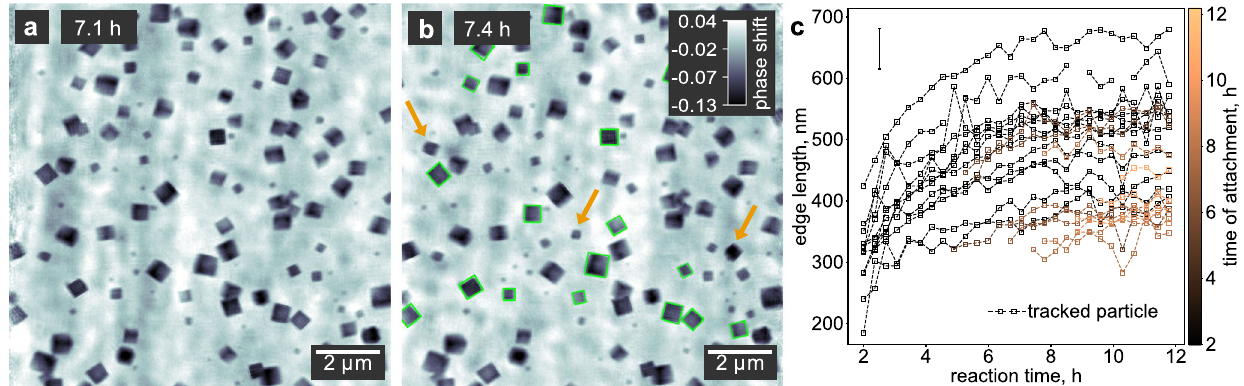
Fig. 3 | Analysis of the growth process from a 2D perspective. a , b In situ ptychographic images taken at 7.1 and 7.4h, respectively. Particles marked with arrows appear in b but are not seen in a , indicating that they attached from the solution onto the reactor window. The gray scale indicates the phase shift of the images in radian. We used nanocubes highlighted with green rectangles for size